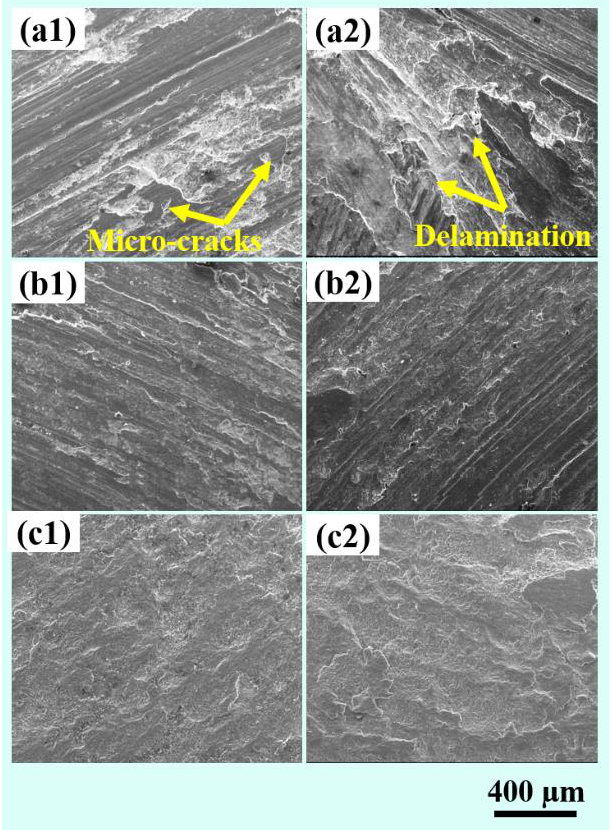
Figure 6. Worn out surface of the cast alloys in GDC, LPSC, an HPSC at two different load conditions 20 N ( a1 , b1 and c1 ) and 60 N ( a2 , b2 and c2 ) at a higher operating temperature of 200